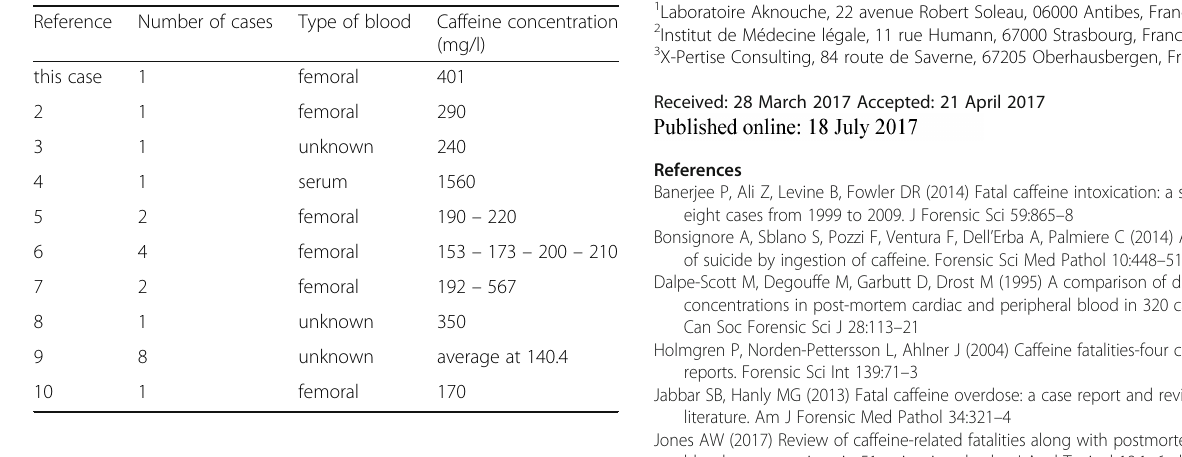
Table 1 Reported fatal caffeine concentrations in the